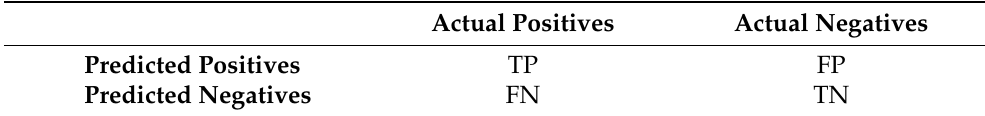
Table 3. Confusion